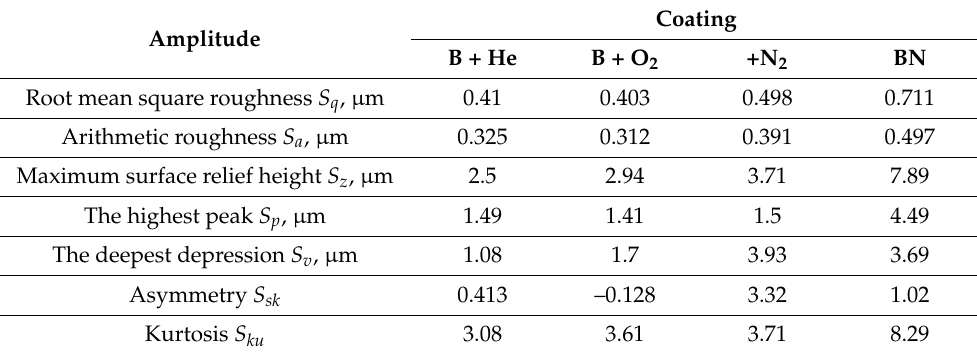
Table 5. Main surface parameters of coatings.